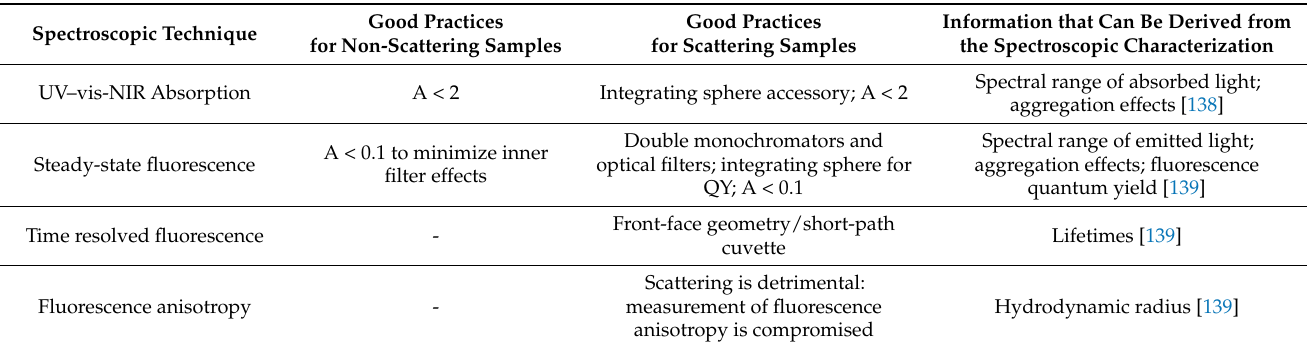
Table 1. Summary of the spectroscopic techniques which are commonly adopted for the investigation of the electronic properties of FONs. A =